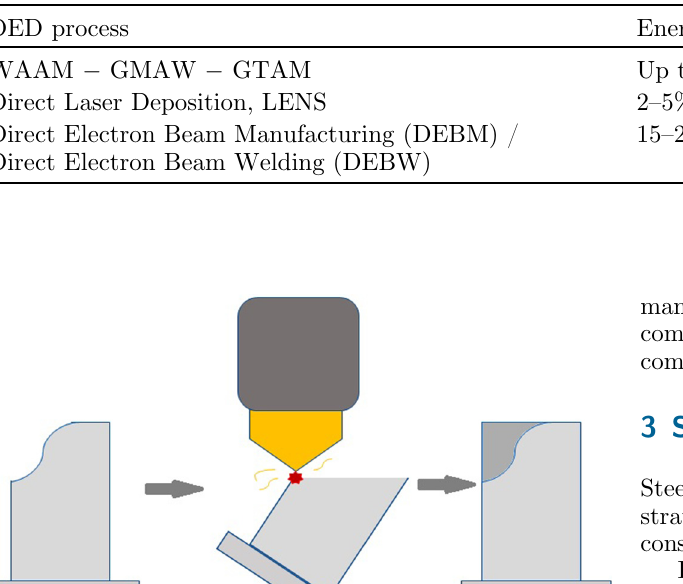
Table 4. Comparison of energy ef fi ciency and deposition rate of DED processes.